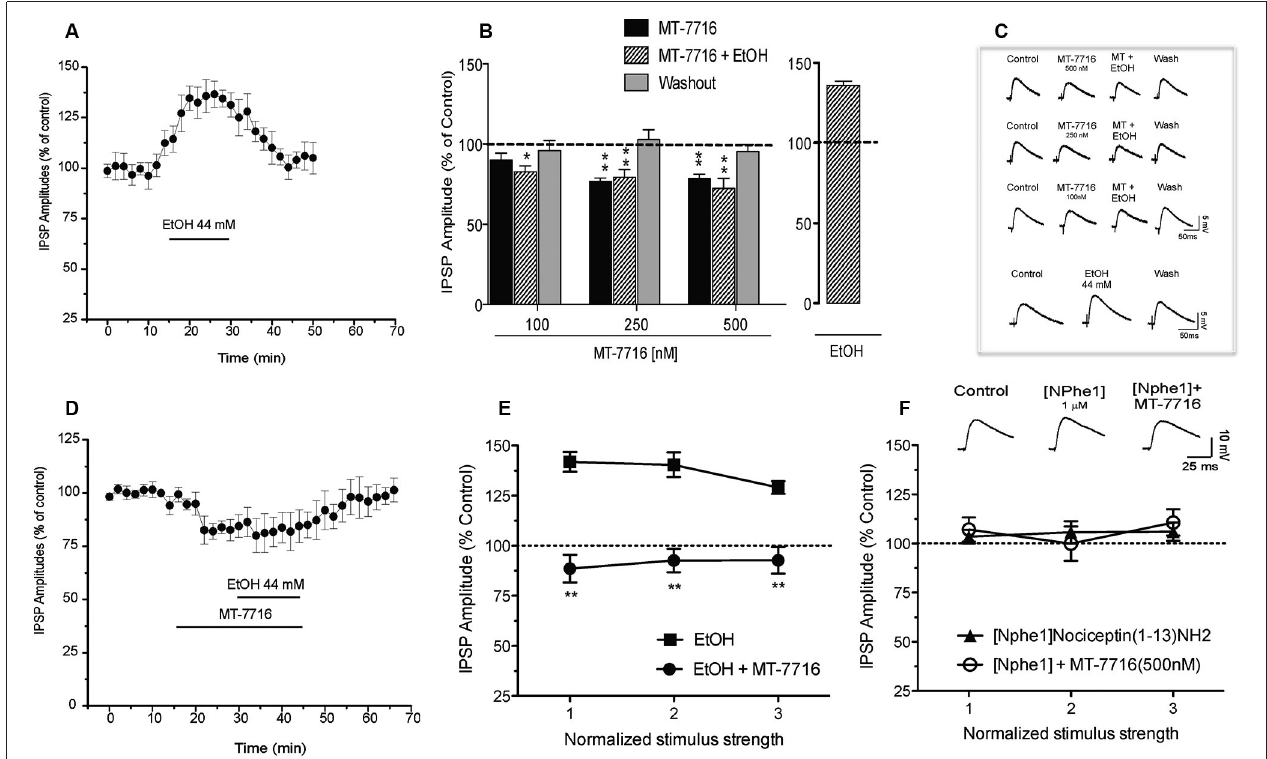
application of MT-7716 (500 nM) that reduces the amplitude of evoked IPSPs. After 15–20 min of MT-7716 superfusion, co-application of ethanol does not increase the evoked IPSP amplitude (72.9 ± 1.1% of control). MT-7716 effectively blocks the ethanol-induced enhancement of IPSPs, and GABA transmission returned to baseline levels upon 25 min of washout (94 ± 10% of control). (E) Ethanol significantly ( p < 0.05) increased (137.1 ± 4.7% of control) the evoked IPSPs and 500 nM MT-7716 in the presence of ethanol significantly (** p < 0.01 by Newman-Keuls post-hoc test) decreased (91.3 ± 1.4%) the IPSPs and blocked the ethanol-induced facilitation. (F) Application of [Nphe1]Nociceptin(1–13)NH2 alone did not alter evoked IPSPs (105.1 ± 4.6% of control); n = 7; by paired t -test but blocked the MT-7716-induced decrease of